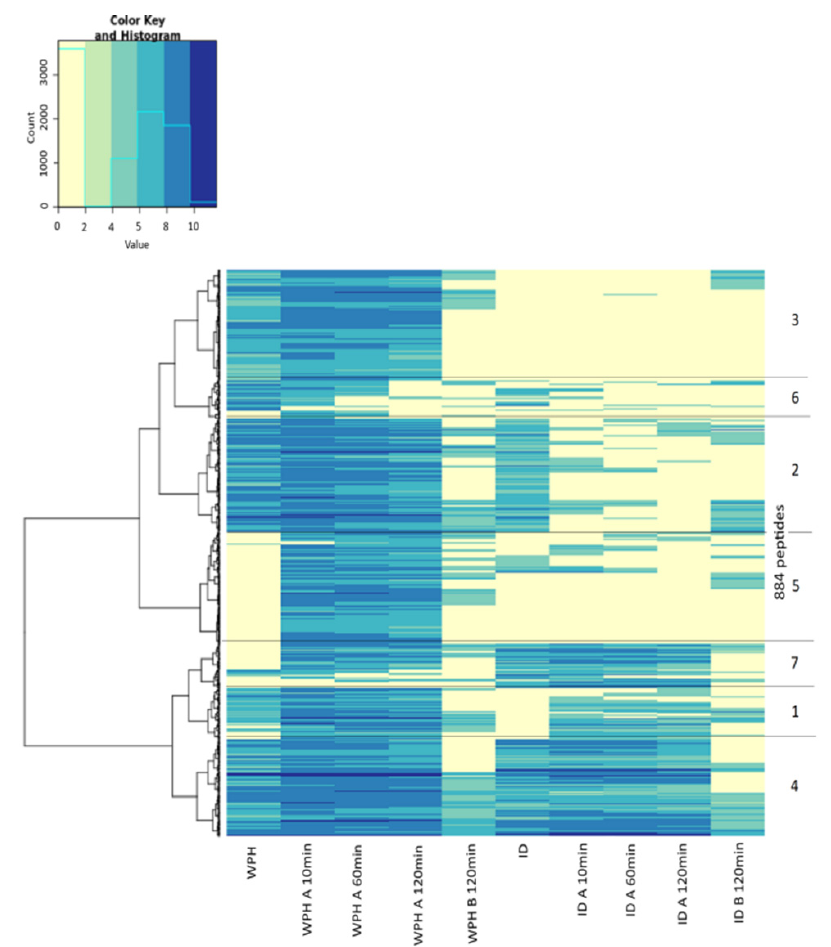
Figure 1. NanoLC–MS/MS heatmap showing all the peptides identified as a function of time in the Ussing chamber (UC) resulting from undigested (WPH) and previously digested (ID) whey protein hydrolysates: these are assembled into one of 7 groups based on similarity which reflects the protein source. Each horizontal line represents a peptide sequenced. Samples are distinguished by the letter A: apical compartment or B: basolateral compartment and sampling time (10 to 120 min).